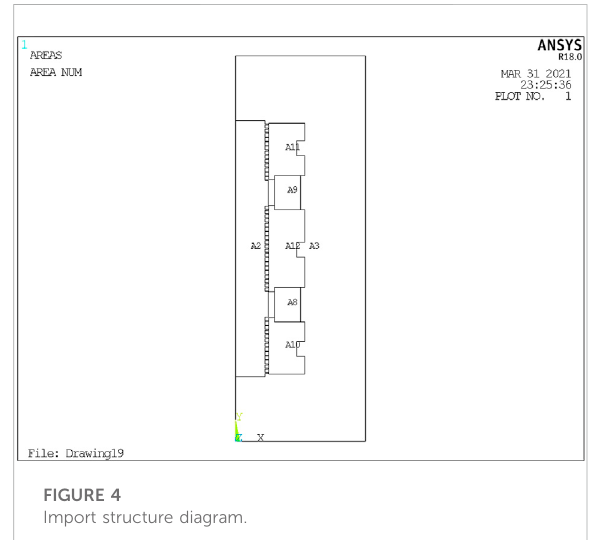
FIGURE 3 B – H curve of 2Cr13.